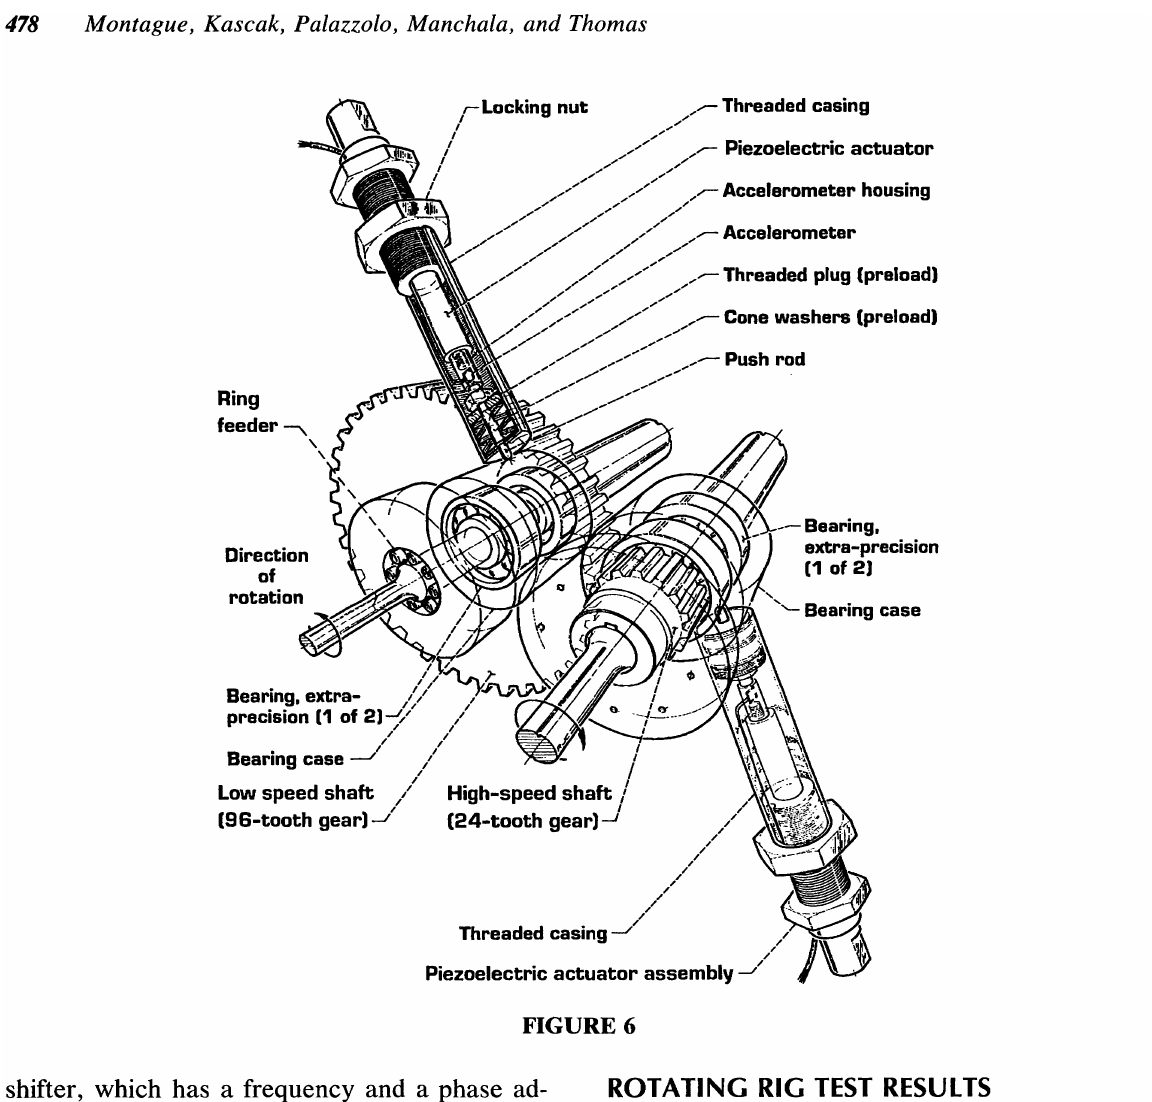
ROTATING RIG TEST